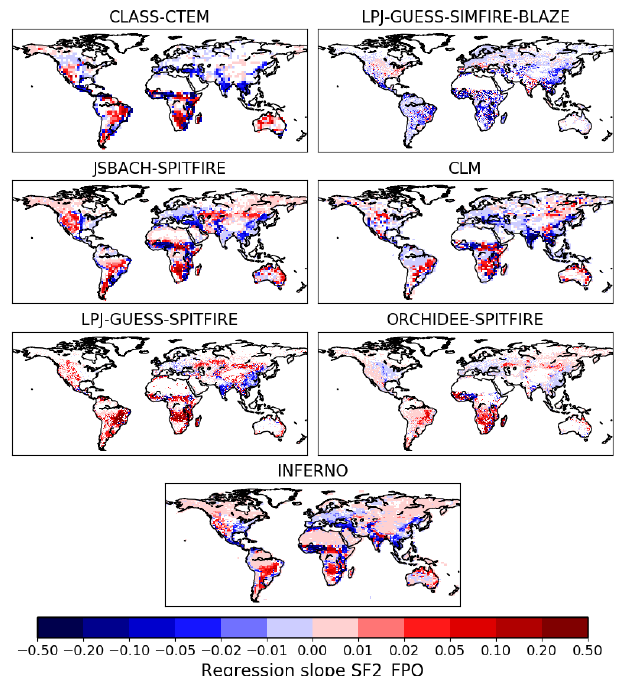
Figure A4. Spatial distribution of regression slopes for the difference between the baseline experiment SF1 and the sensitivity experiment SF2_FPO (SF1–SF2_FPO; see Table 1) over